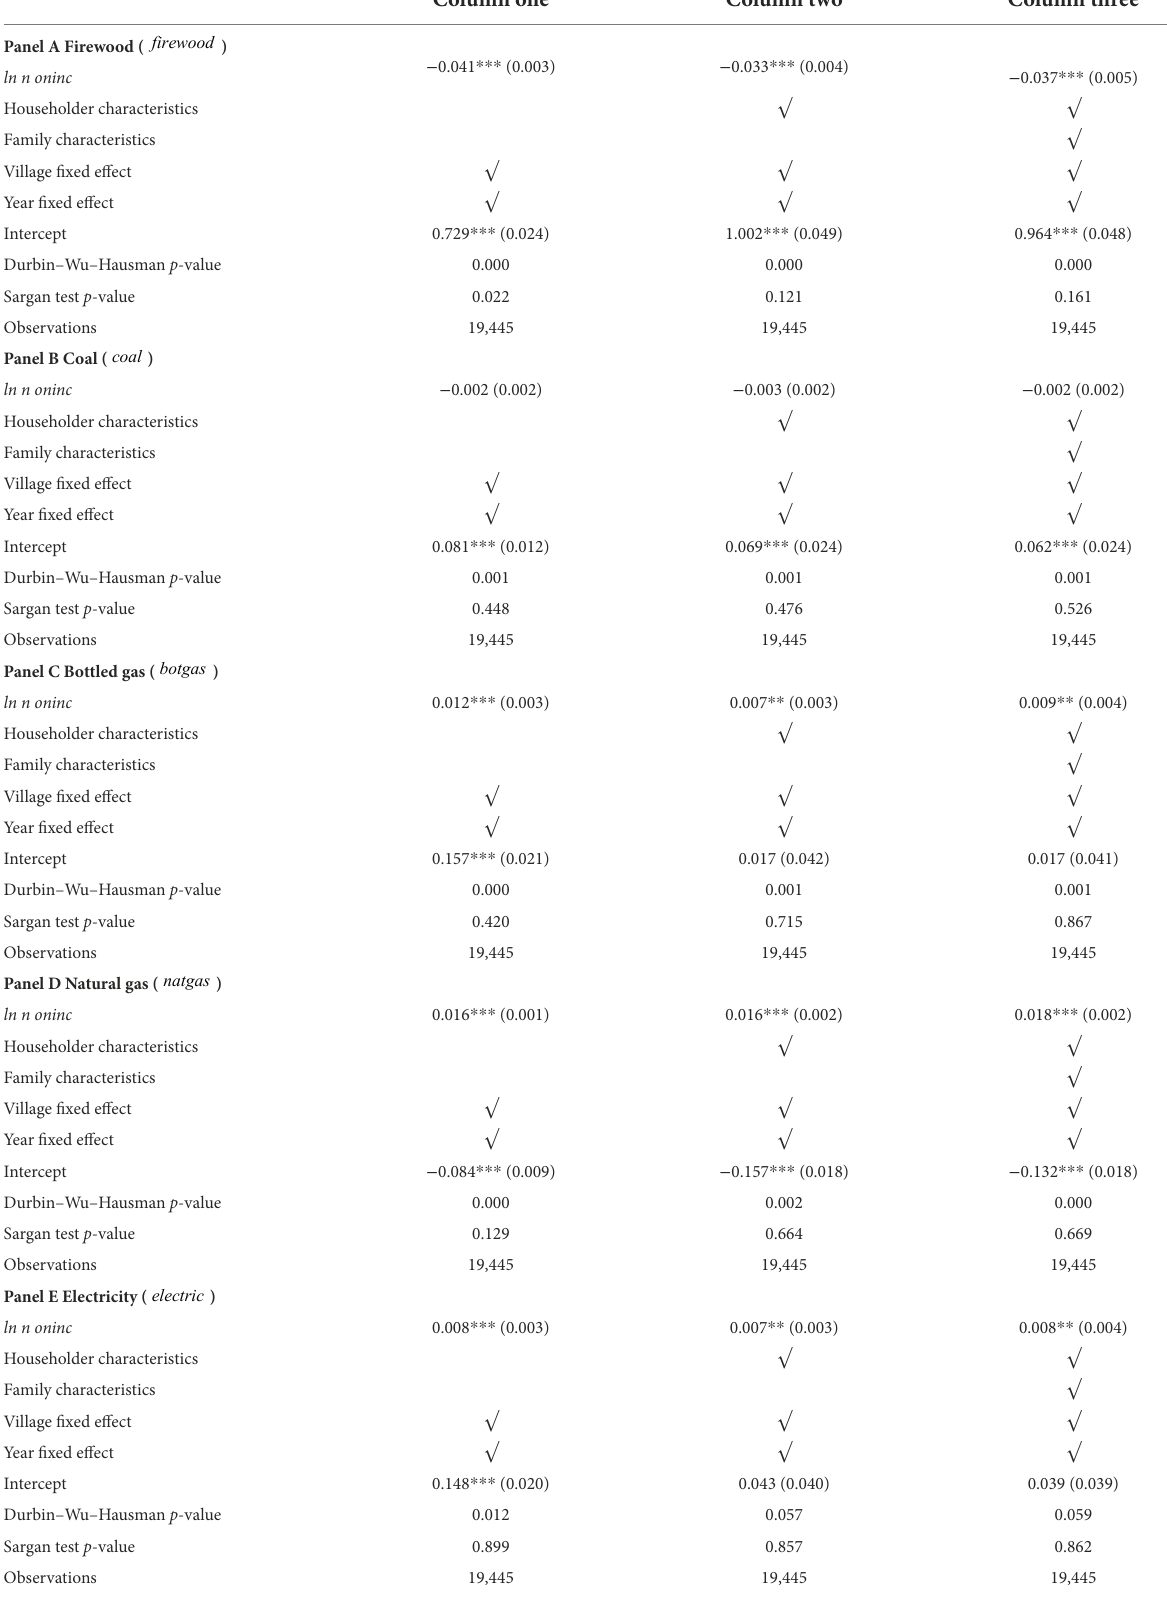
TABLE 4 IV estimation results of the second stage. Column one Column two Column